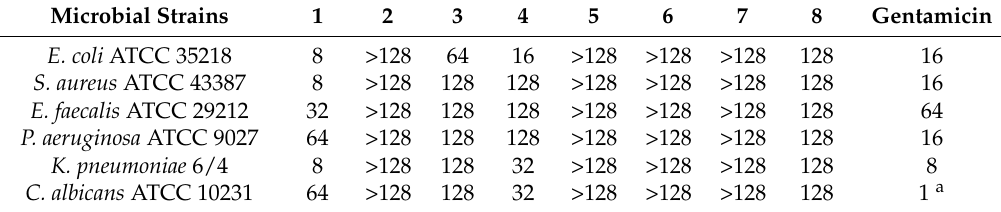
Table 1. Minimum Inhibitory Concentration (MIC) values ( µ g/mL) of the tested compounds against selected microbial strains, assessed by broth microdilution method according to the Performance Standards for Antimicrobial Susceptibility Testing (CLSI Document M100-S2, 2013). Gentamicin and fluconazole were used as internal